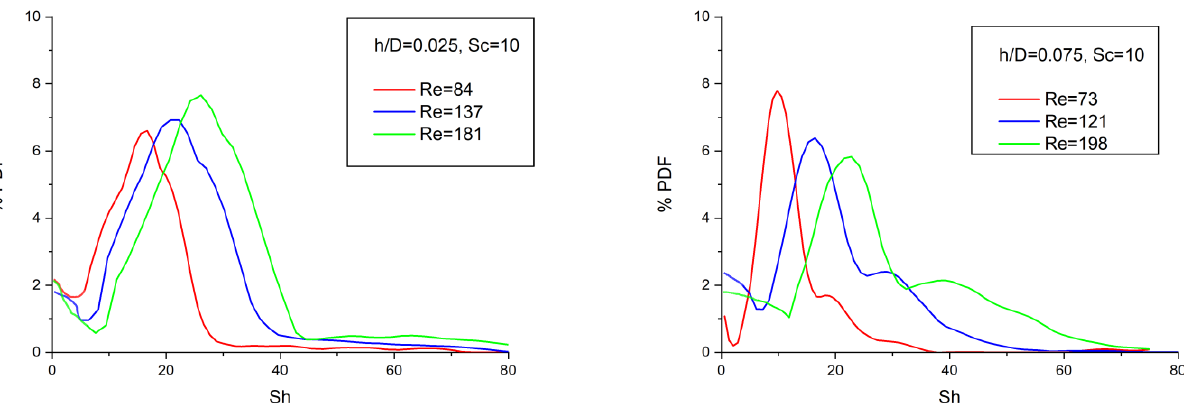
Figure 5. Percent probability density function of the dimensionless local time-averaged shear stresses on the membrane surface for the cases examined in this work. Shear stresses are normalized with the quantity μU/D.